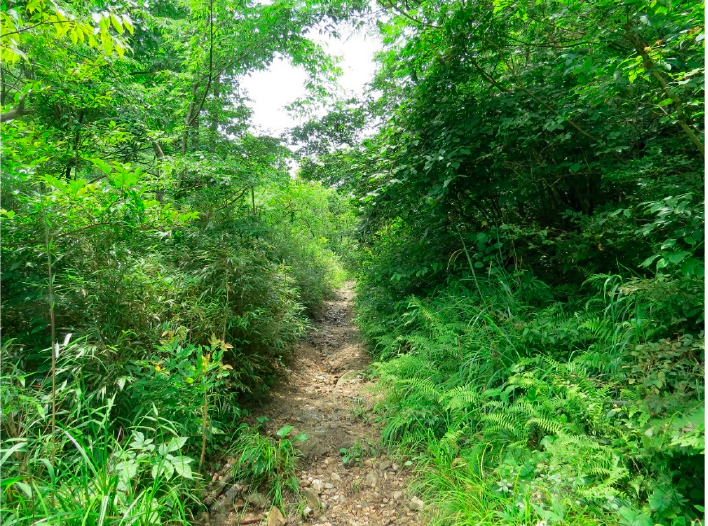
Figure 5. Habitat of Achalinus dabieshanensis sp. nov . in its type locality in the Dabie Mountains, Anhui, China (Photography by Baowei Zhang).